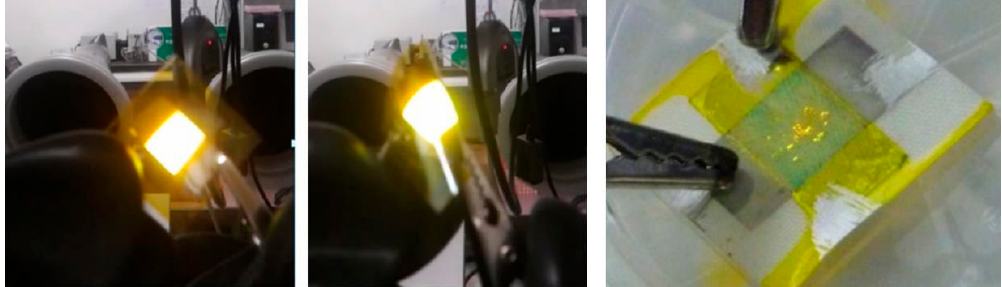
Figure 7. From left to right: OLED on PET (polyethylene terephthalate) just after deposition; OLED on PET showing the stable light emission even during flexing and bending; OLED stack printed on textile.